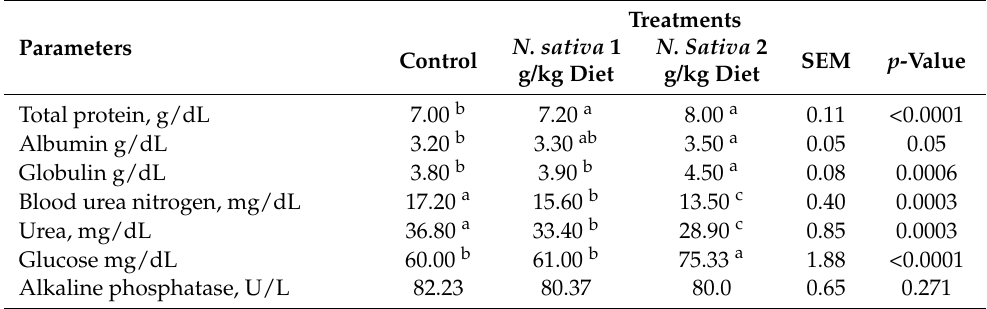
Table 5. Effects of N. sativa (10.0 and 20 g/kg diet) on blood biochemistry of Ardi goats in